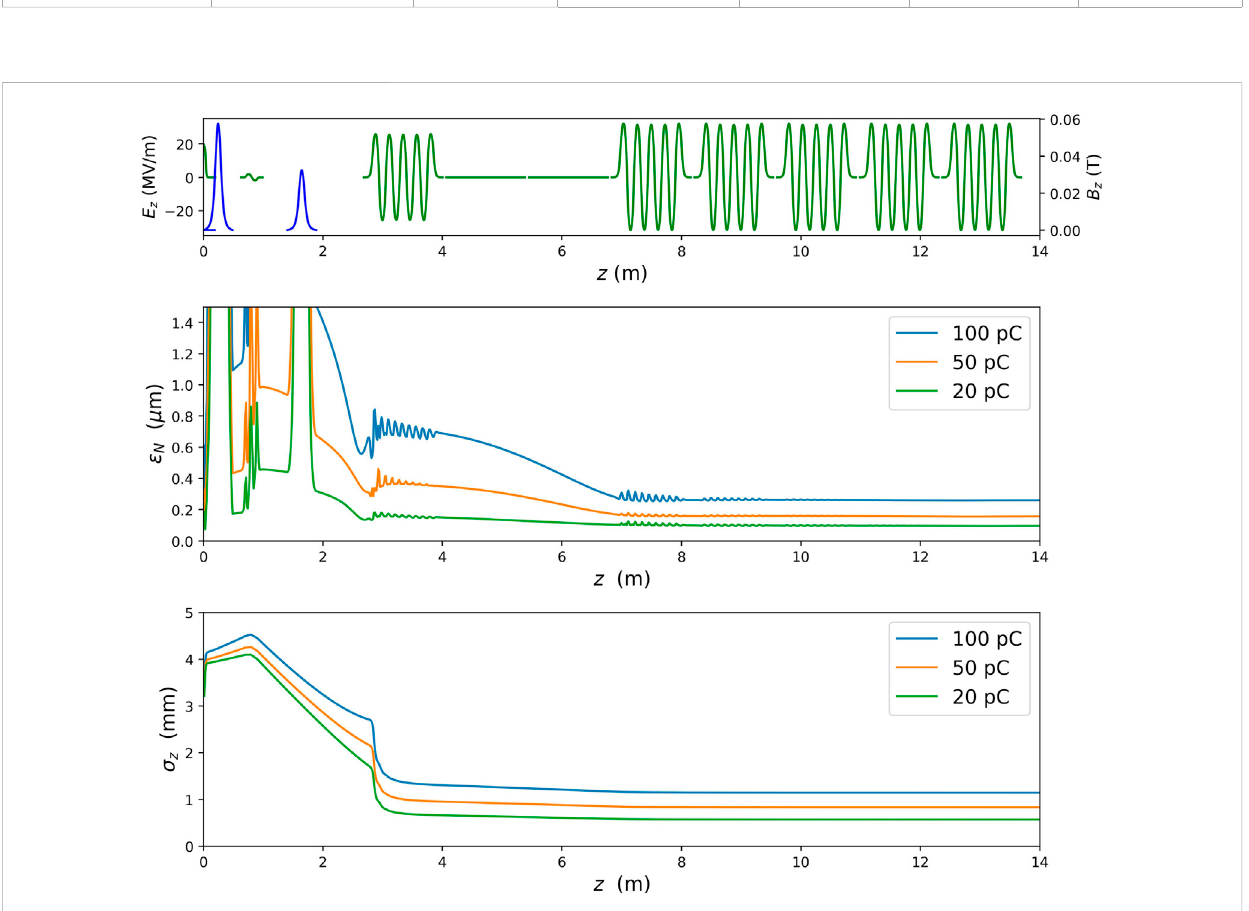
FIGURE 5 Electric and solenoid fi eld (top), normalized emittance (middle) and rms bunch length (bottom) of three beam charges in the multiplexed con fi guration with customized laser spot size (case B in group I).